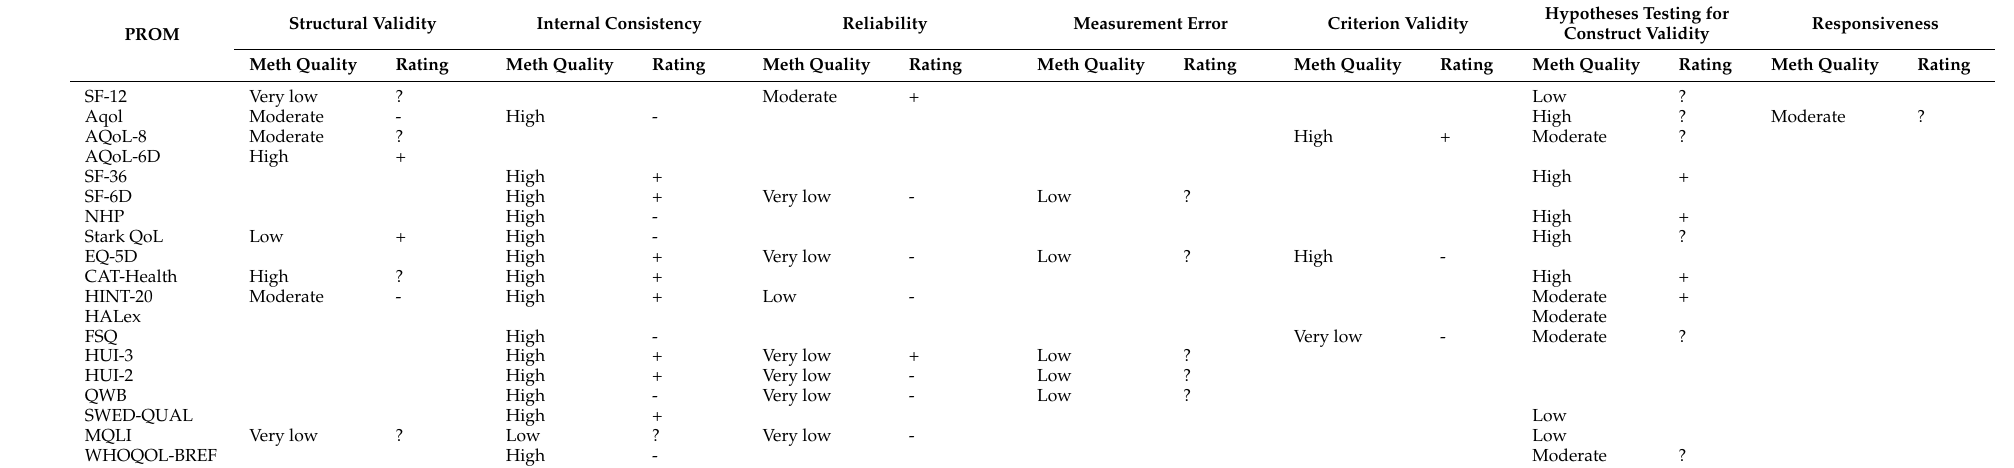
Table 8. Evidence synthesis on measurement properties of HRQOL instruments in general